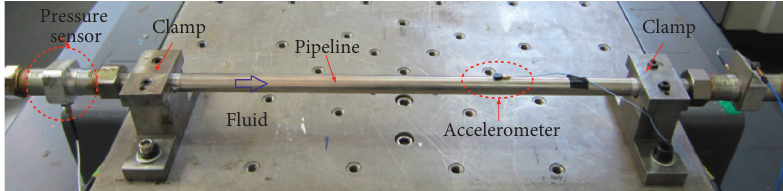
Figure 2: Photograph of test bench layout.